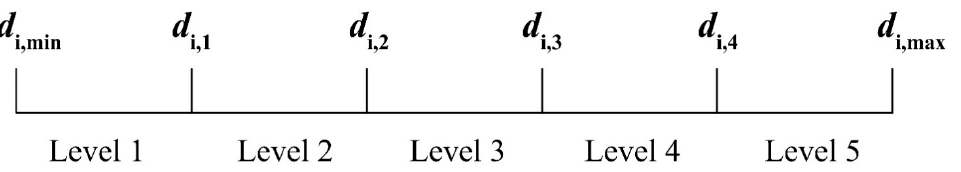
Figure 2. Sub-criteria grade